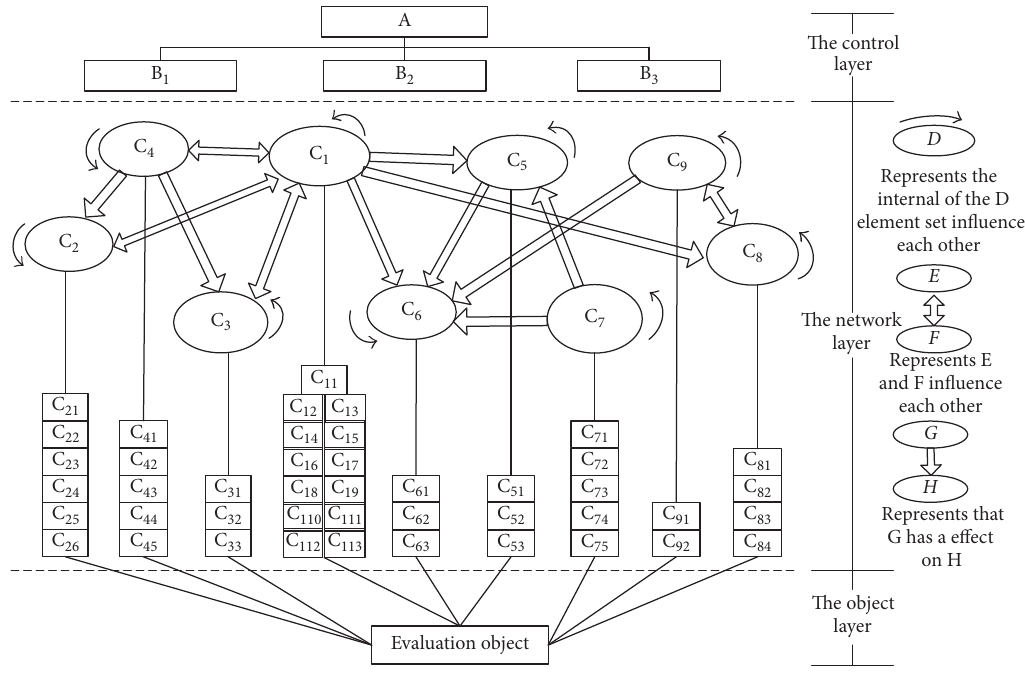
Figure 1: Network structure of ANP of FSSIT.